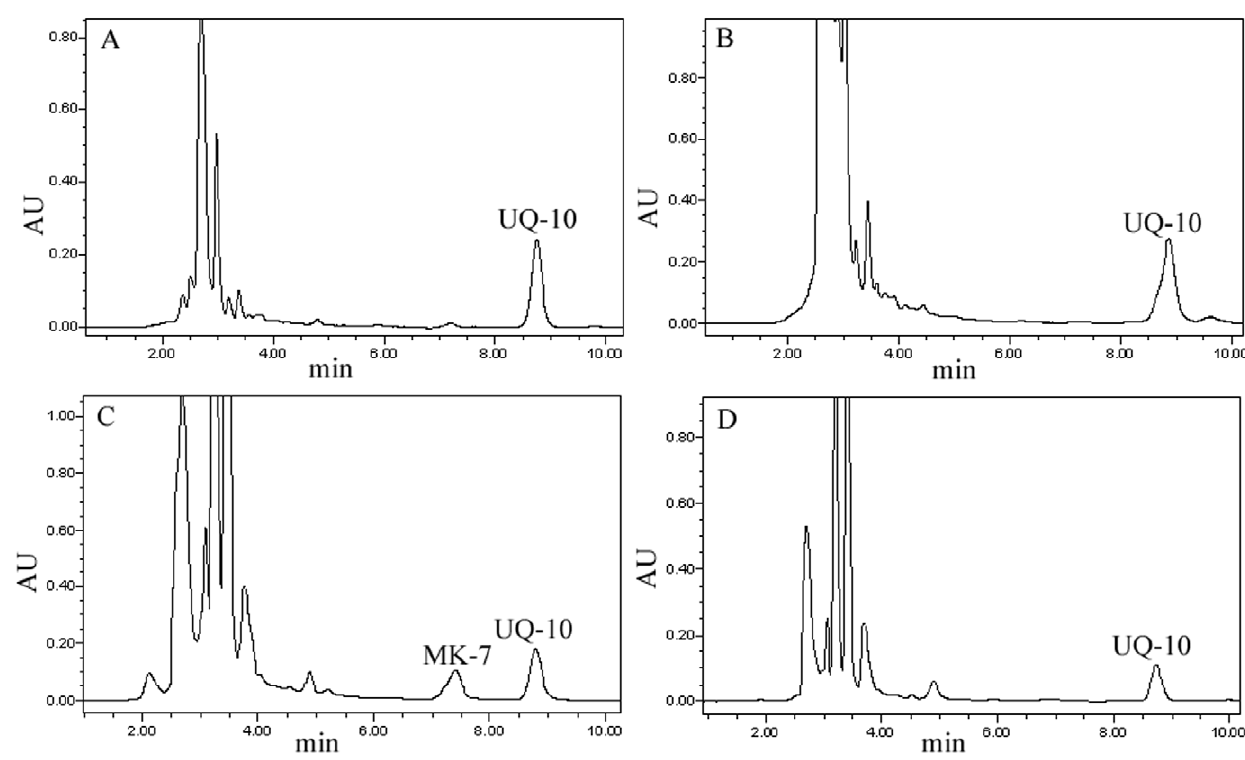
Figure 5. HPLC analyses of MK and UQ from wild type strain 7653R and disruptant HK116 under aerobic and microaerobic conditions. (A) UQ-10 was accumulated in 7653R a under aerobic condition. (B) UQ-10 was accumulated in HK116 under aerobic condition. (C) MK-7 was accumulated in wild type strain 7653R when culturing conditions were shifted to microaerobic for 24 hours. (D) MK-7 was not produced in disruptant HK116 under microaerobic